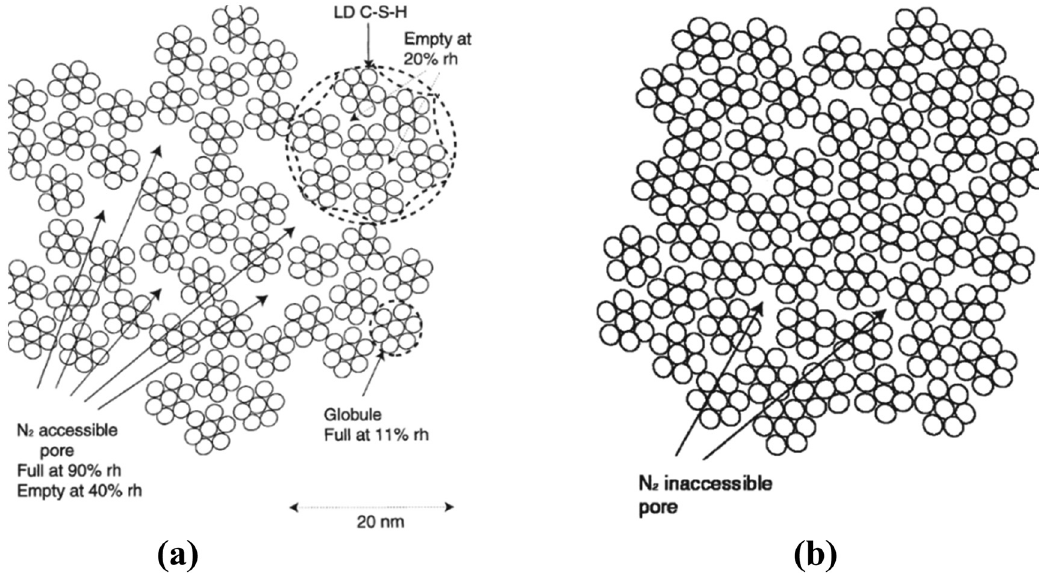
Figure 11: ( a ) 2D schematic of LD C – S – H formed by the late - stage and/or by drying and ( b ) 2D schematic of HD C – S – H, the predominant type of C – S – H that forms during the late - stage at water/cement ratio = 0.4, reprinted with permission from ref. [ 118 ] ; Copyright 2000, Else - vier